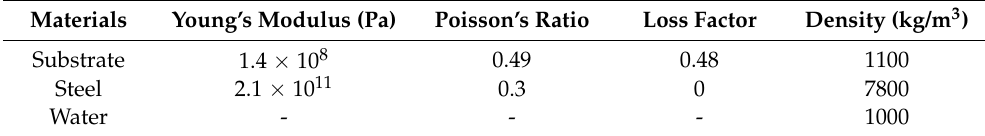
Table 1. Material parameters.